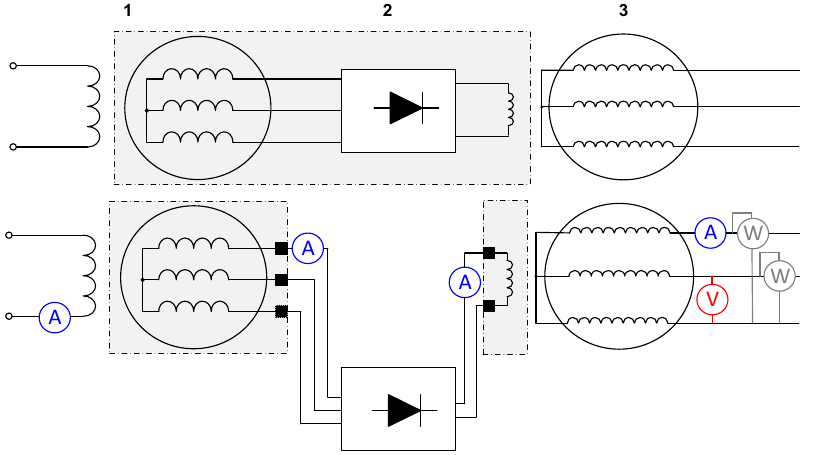
Figure 12. BSM schematic representation. On top, of the regular arrangement, and on the bottom, the experimental setup ((1) Exciter; (2) bridge rectifier; (3) main machine). Rotating elements are contained in gray sections.